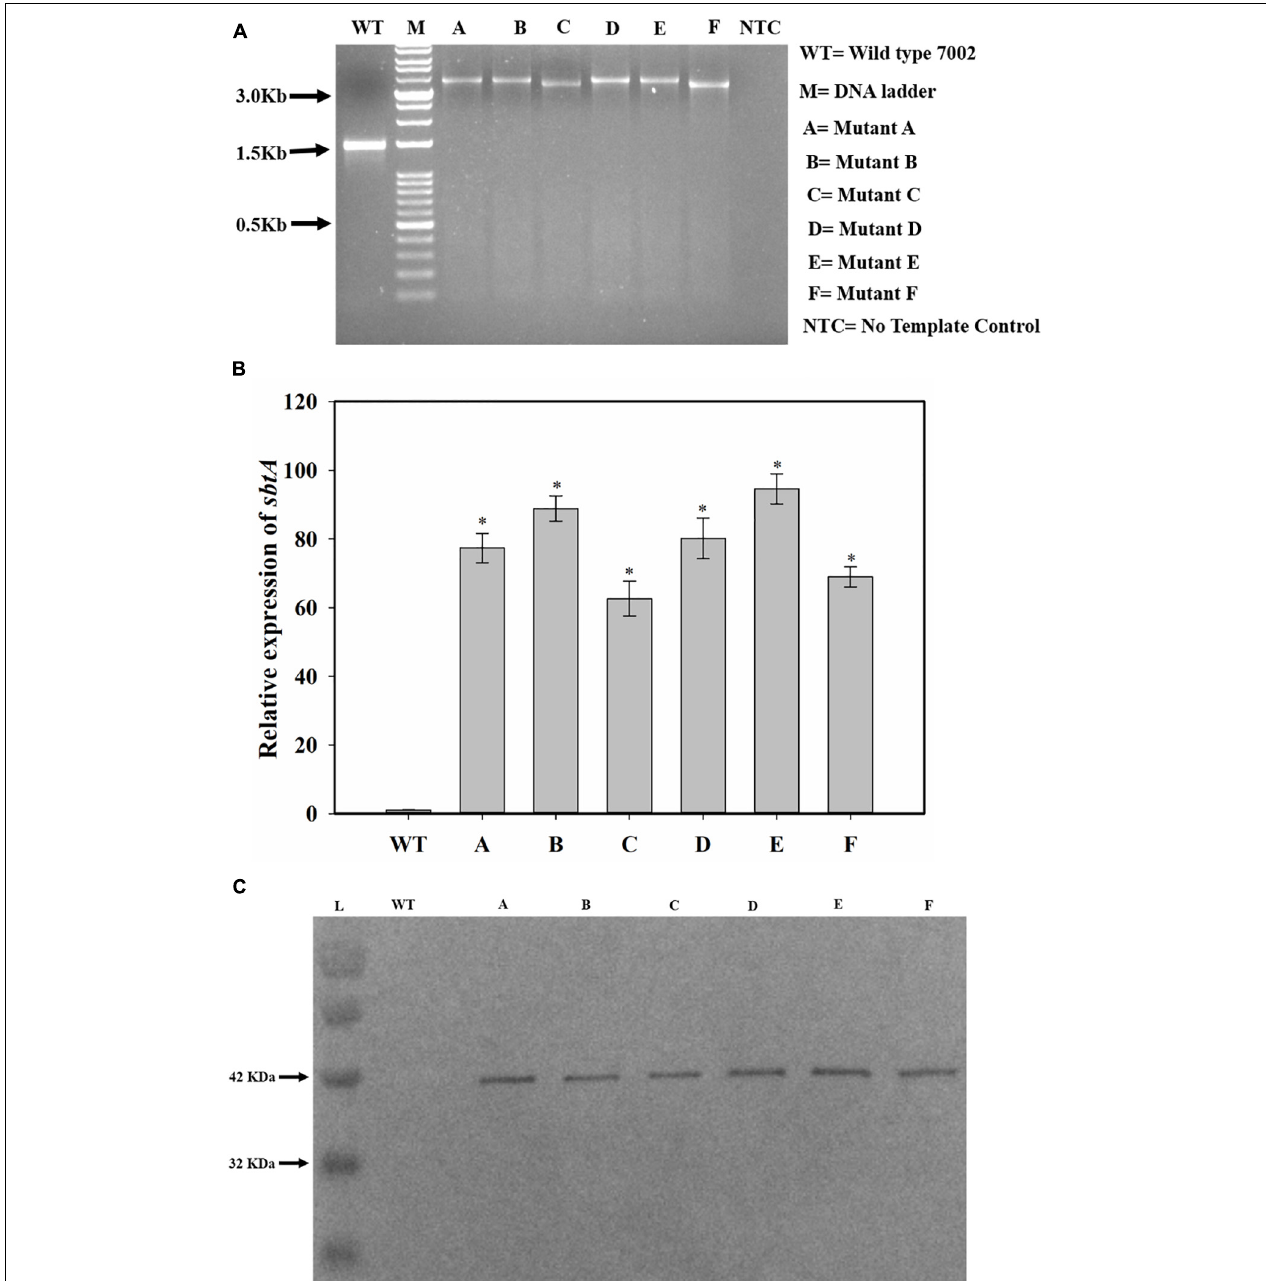
FIGURE 2 | Screening and confirmation of transformants. (A) Screening for integration of gene cassette by genomic DNA PCR. sbtA gene constructs with different promoters and RBS, containing kanamycin resistance gene as the selection marker were cloned between NSI and NSII in PCC 7002 cells by homologous recombination. The whole insert was PCR amplified using forward primer for NSI and reverse primer for NSII. M is DNA molecular weight marker. Lanes WT, A, B, C, D, E, and F represent the PCR product upon using the genomic DNA from PCC 7002, A, B, C, D, E, and F cells, respectively, as the template. NTC is the no template control in which no DNA template was added. (B) Measurement of relative levels of sbtA mRNA in the strains A to F by qRT-PCR, n = 3. * p < 0.05 compared to WT PCC 7002 cells. (C) Expression of His-tagged SbtA protein in different strains was measured by Western blotting. L = Protein molecular weight marker. Lanes WT, A, B, C, D, E, and F represent proteins extracted from WT PCC 7002, A, B, C, D, E, and F cells, respectively.